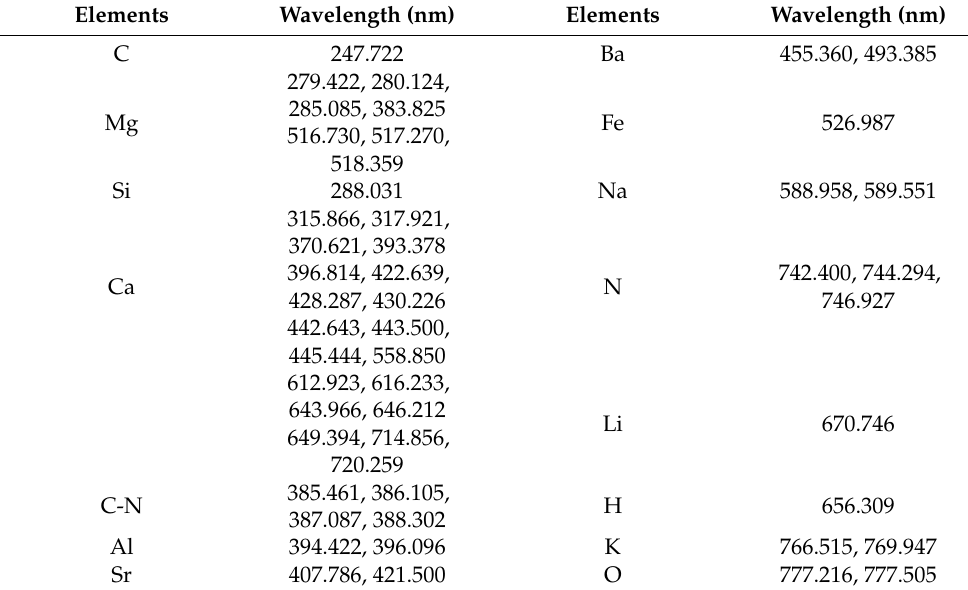
Table 1. Selected spectral lines of LIBS Spectra.